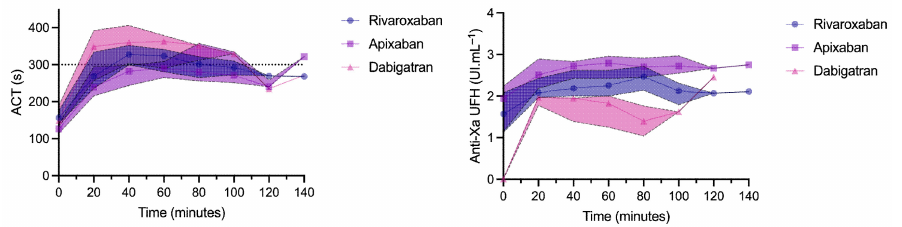
Figure 3. Evolution of activated clotting time (ACT) and unfractionated heparin (UFH) anti-Xa activity during the procedure. Results are expressed as median and interquartile